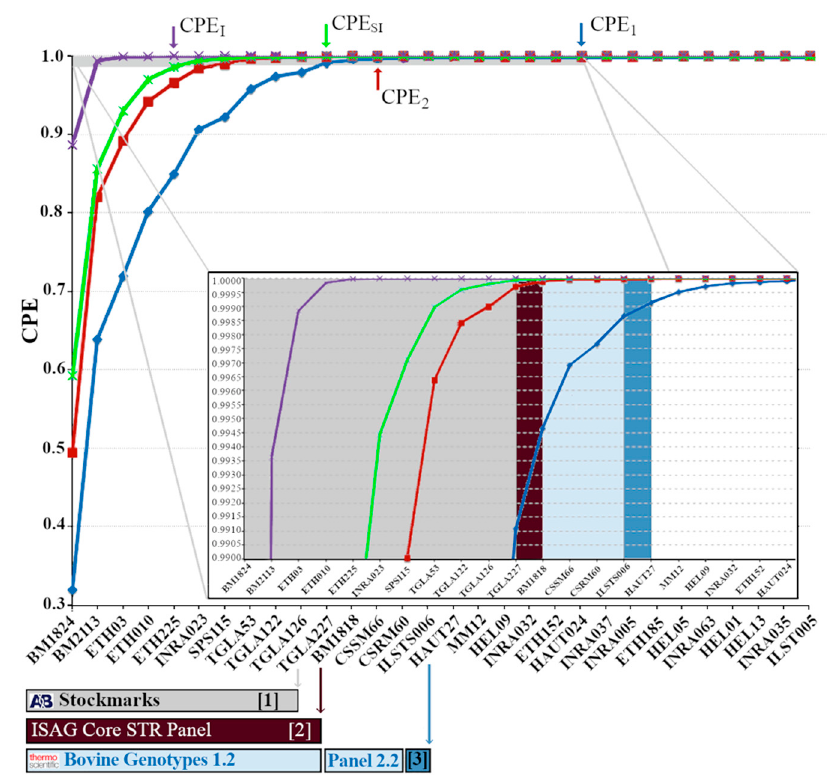
Figure 2. Comparison of combined power of exclusions (CPE) between the panels of short tandem repeat markers. Short tandem repeats (STRs) considering one known parent, two known parents, sibling and identical are shown in blue (CPE 1 ), red (CPE 2 ), green (CPE SI ), and purple (CPE I = 1 − CMP) cases, respectively. Little arrows (top) show the minimal number of markers for 99.99% of CPE. Boxes (below) show the markers included in recommended and commercial STR panels (grey, Stockmarks; garnet, ISAG core; blue, Bovine genotype 1.2 and 2.2). Numbers in brackets shows other panels used in literature.